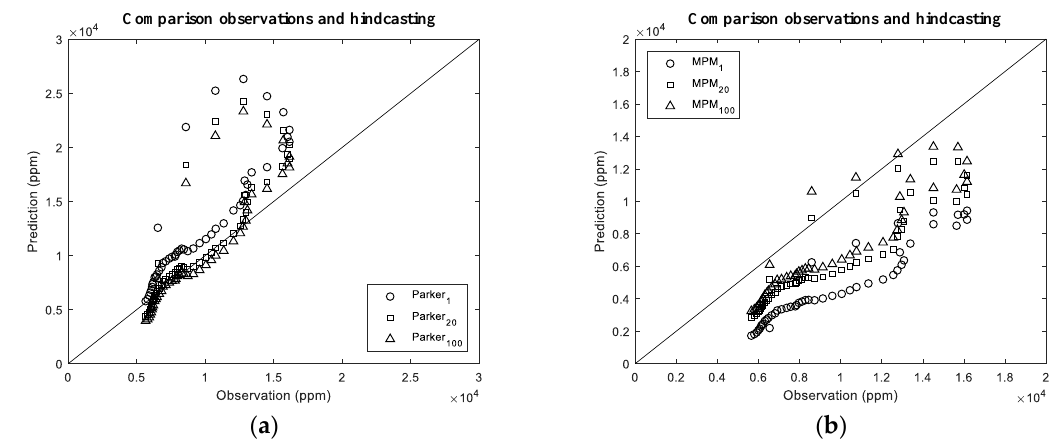
Figure 7. Simulation performance obtained from different ensemble sizes in Dahan River, ( a ) Parker; ( b ) MPM.